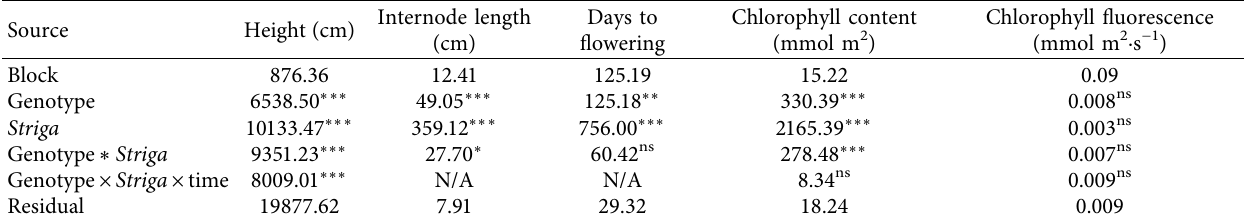
Table 6: Effect of S. asiatica on the days to flowering of sorghum. Treatment